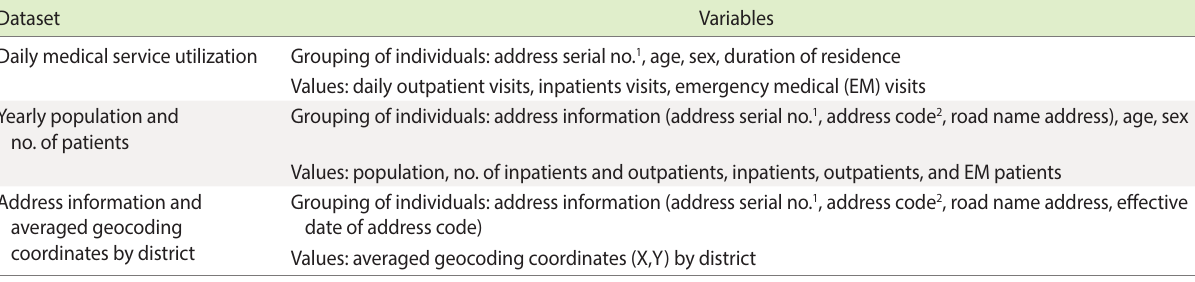
Table 1. Components of the Allergic Disease Dataset